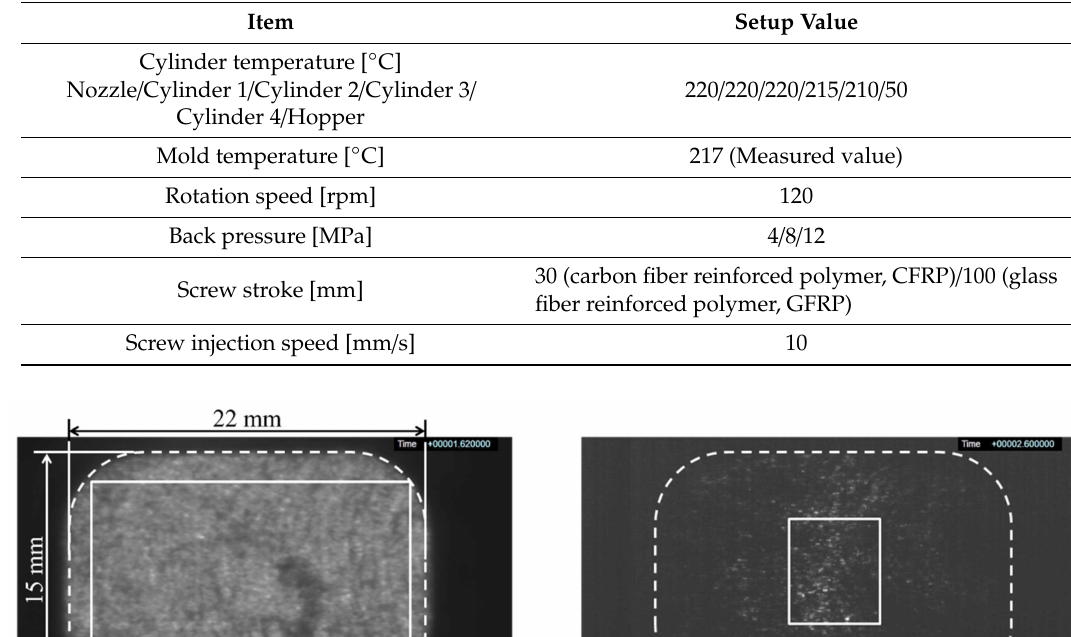
Table 1. Molding conditions.